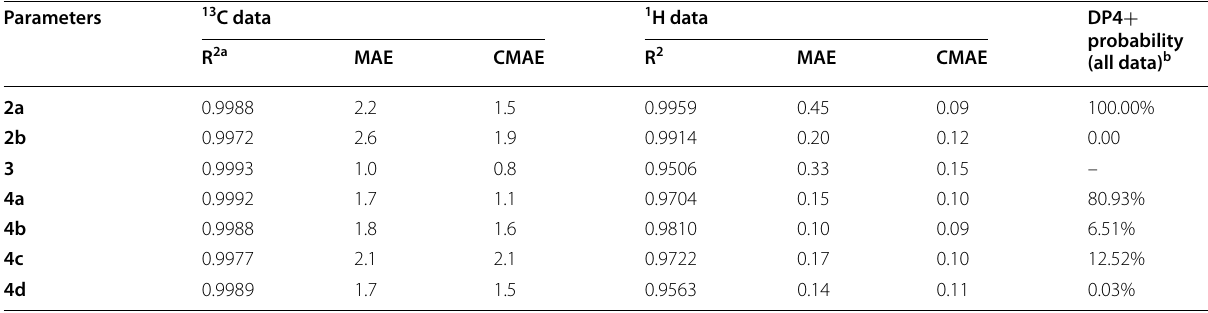
MAE: Mean Absolute Error, CMAE : Corrected Mean Absolute Error a R 2 : squared Pearson correlation coefficient between experimental and calculated NMR chemical shifts b DP4 probability (all data): DP4 probability based on analyzing 1 H or 13 C data together. If 1 H chemical shifts of CH 2 , which were prone to error when assigning, are + + removed from analysis, the DP4